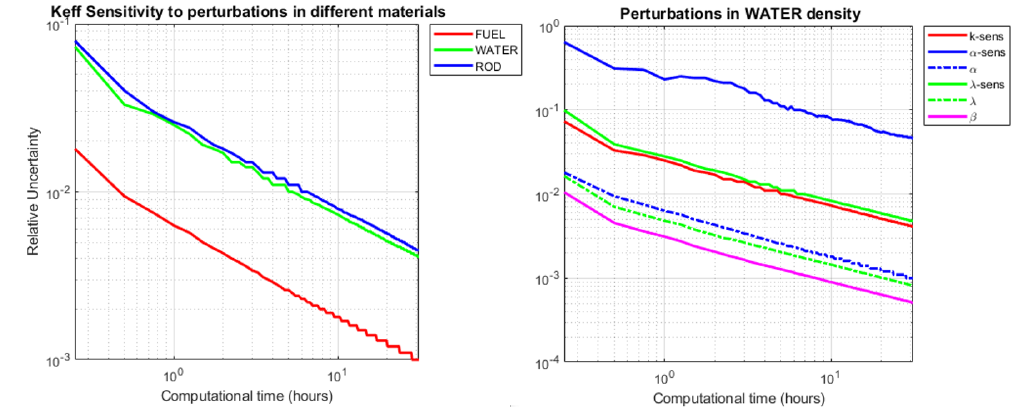
Figure 5: Convergence speed of the main sensitivity